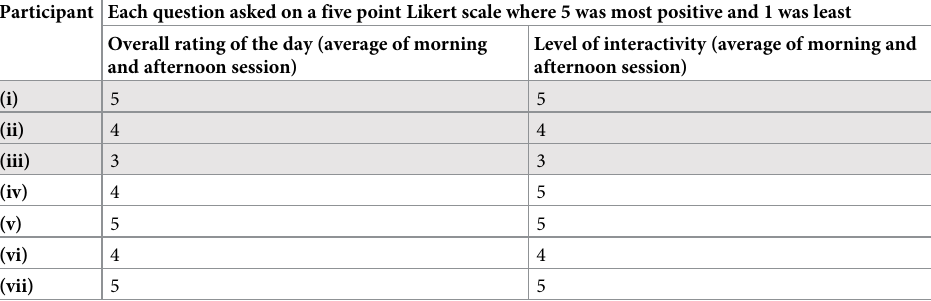
Table 4. Summary of rated quality and interactivity of the day from